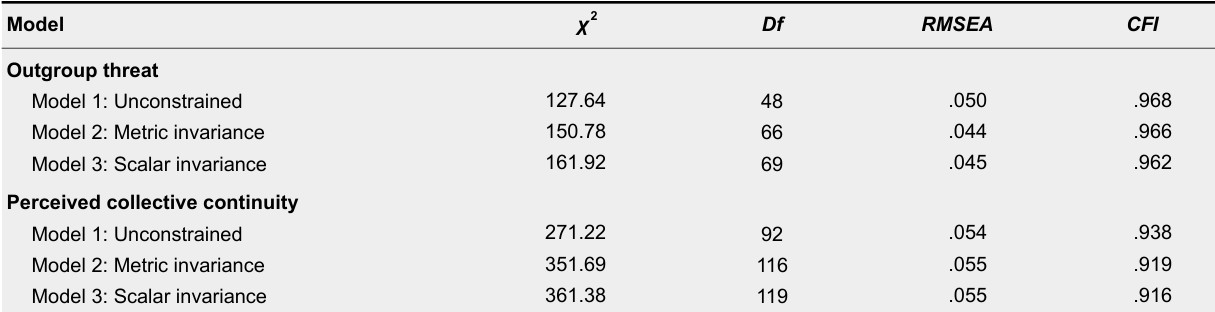
Fit Measures of the Measurement Equivalence